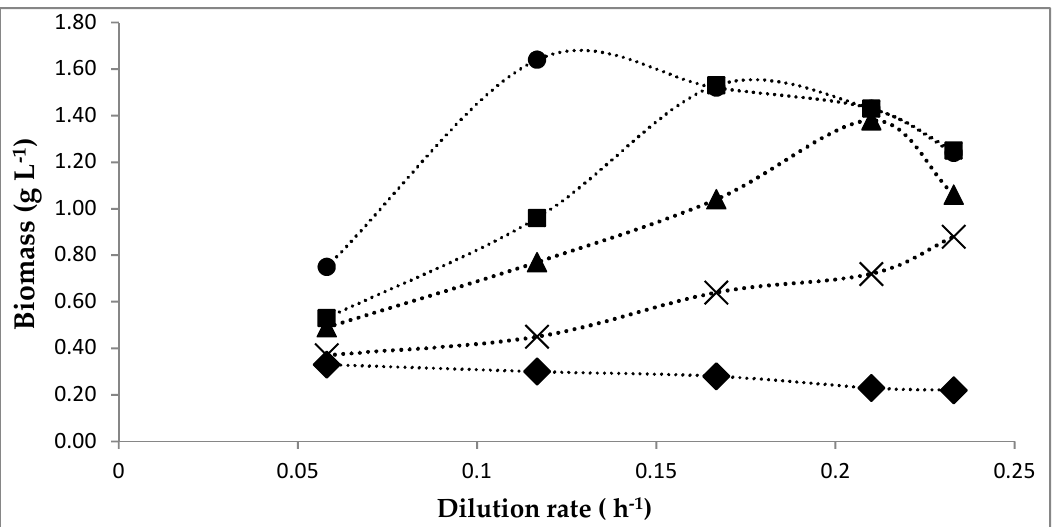
Figure 3. The growth of C.butyricum on glucose media at three concentrations of glucose on steady state ( ◆ ) for 5 g L −1 feed, ( × ) 10 g L −1 feed ( ) 15 g L −1 feed, ( ) 20 g L −1 feed and (•) 28 g L −1 feed.